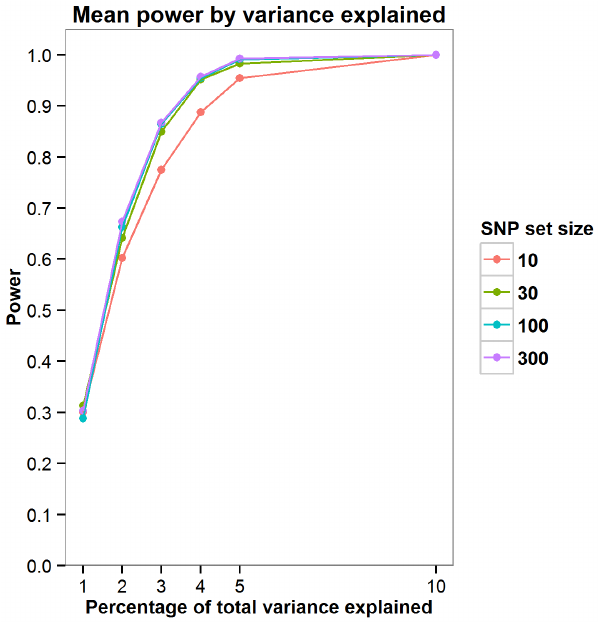
Figure 5. The mean power is plotted against variance explained for the number of SNPs the effect is spread over. As indicated, the total amount of variance explained, rather than the number of SNPs the effect is spread over, influences statistical power.